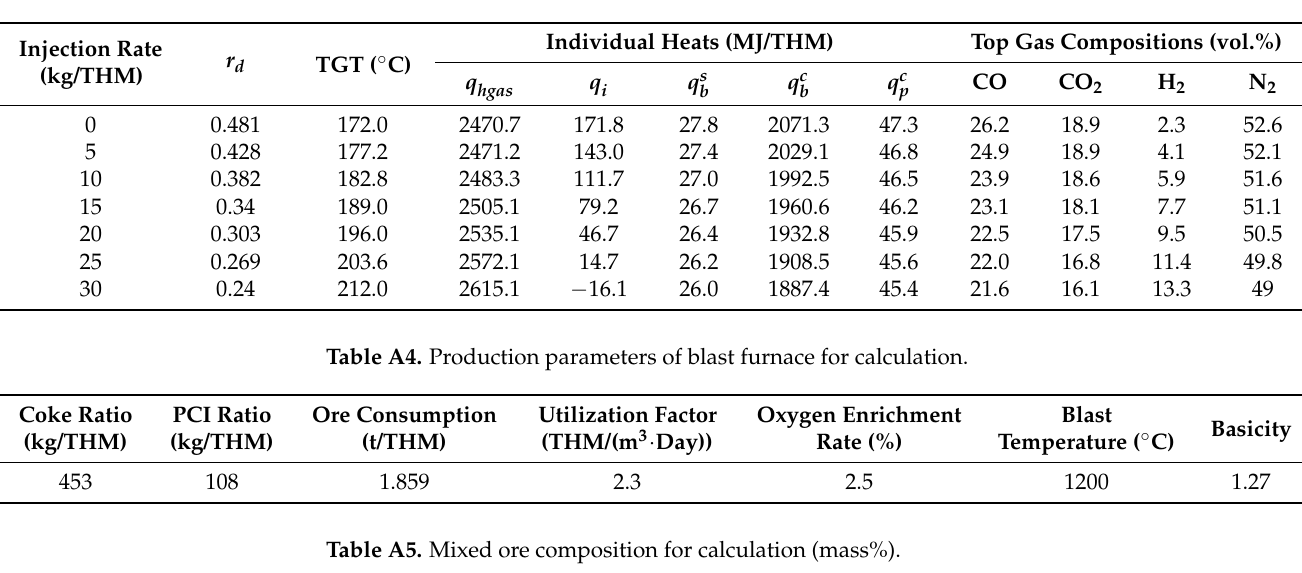
Table A3. Relevant parameter values in the calculation of TGT (injection of hydrogen).